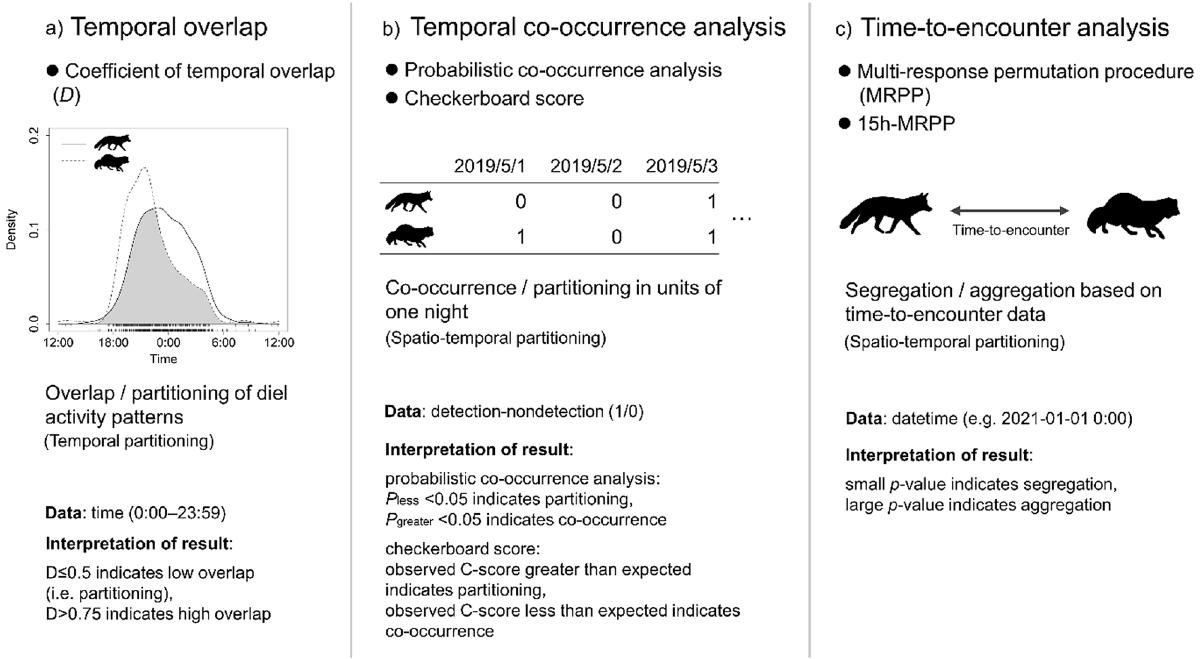
Figure 1. Images illustration and comparison of the different analytical approaches used in this study. The interpretation of results were referred from Monterroso et al . 19 for coefficient of temporal overlap, Griffith et al . 41 for probabilistic co-occurrence analysis, McCreadie et al . 71 for checkerboard score, Karanth et al . 33 for time- to-encounter analysis. The drawing of the kernel density estimation in panel ( a ) is based on the data from this study (see Fig. 3). The silhouette images of the red fox and raccoon dog were public domain data obtained from PhyloPic (http:// phylo pic.